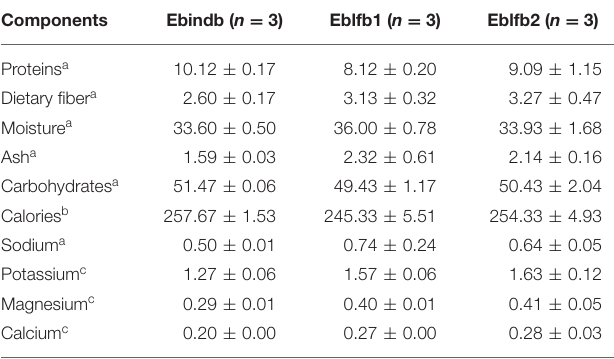
TABLE 3 | Chemical properties of the three different tested